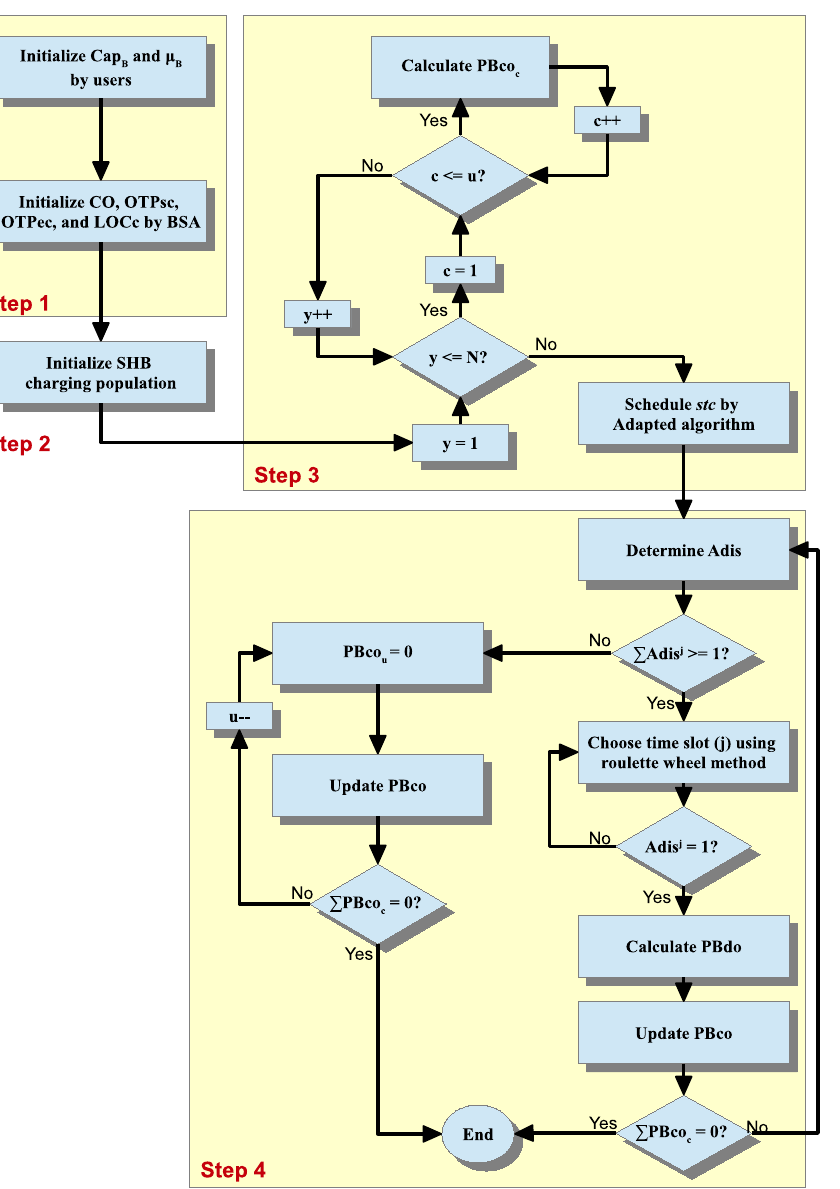
Figure 3. Flow chart of the proposed SHB scheduling algorithm